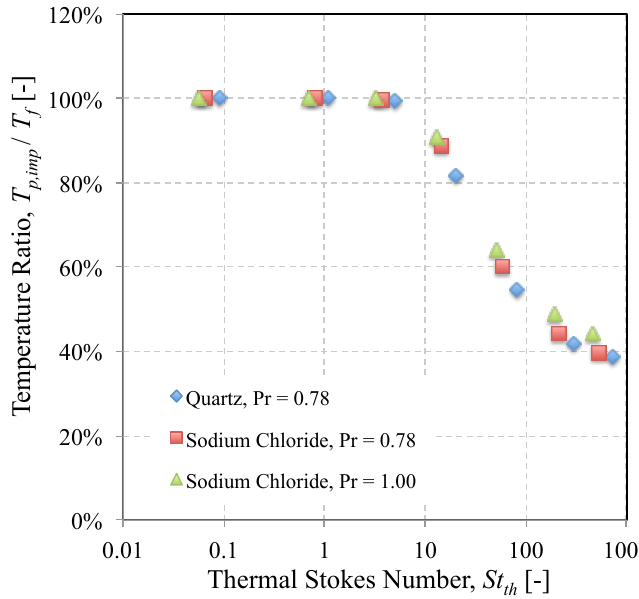
Figure 9. Variation of the temperature ratio as a function of thermal Stokes number for two minerals and two Prandtl